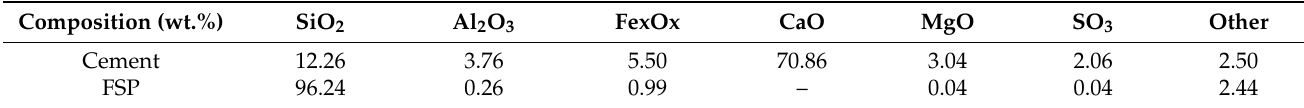
Table 1. Chemical properties of cement and